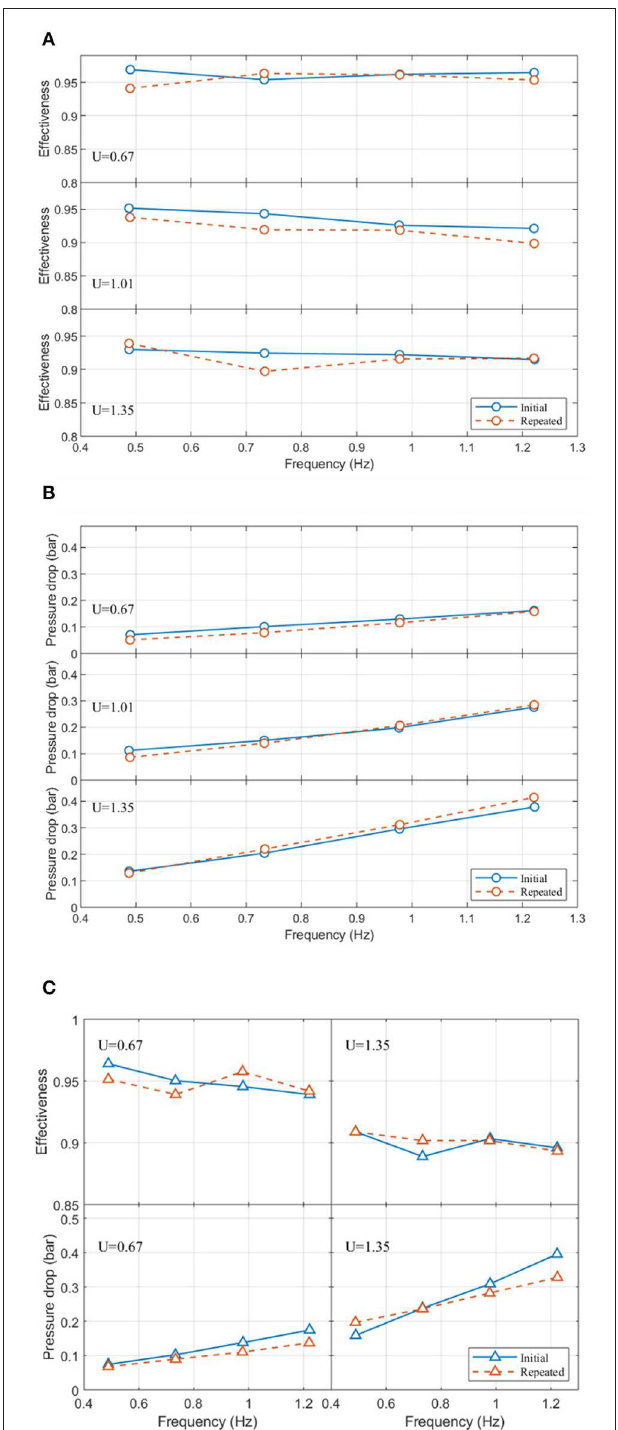
FIGURE 9 | Effectiveness (A) and pressure drop amplitude (B) comparisons between initial test and repeated test under utilizations of 0.67, 1.01, and 1.35 in regenerator #1. The curve marked “repeated” stands for a repeated passive test after about 300h of passive testing. (C) Effectiveness and pressure drop amplitude comparisons between initial test and repeated tests under utilizations of 0.67 and 1.35 in regenerator #4. The reproducing experiment was done after nearly 700h of passive testing and 120h of active